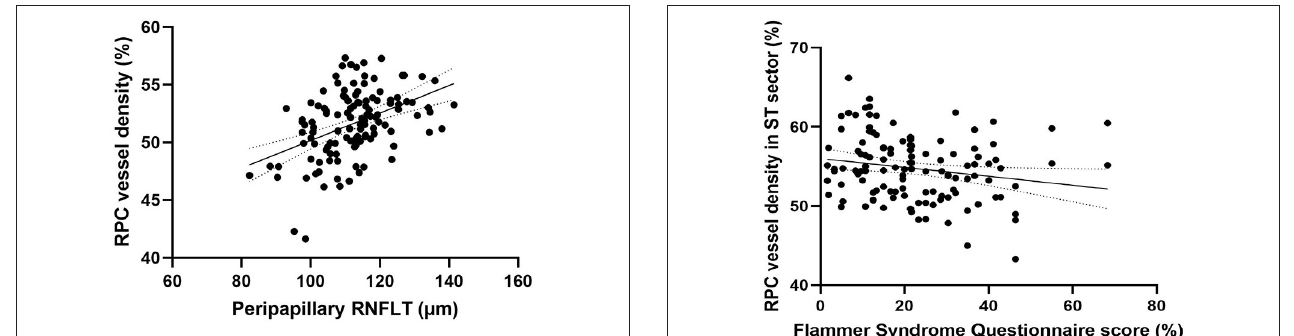
FIGURE 4 | Correlation matrix performed by spearman analysis between Flammer Syndrome questionnaire score and RPC vessel density in the superotemperal sector ( r = − 0.214, p =